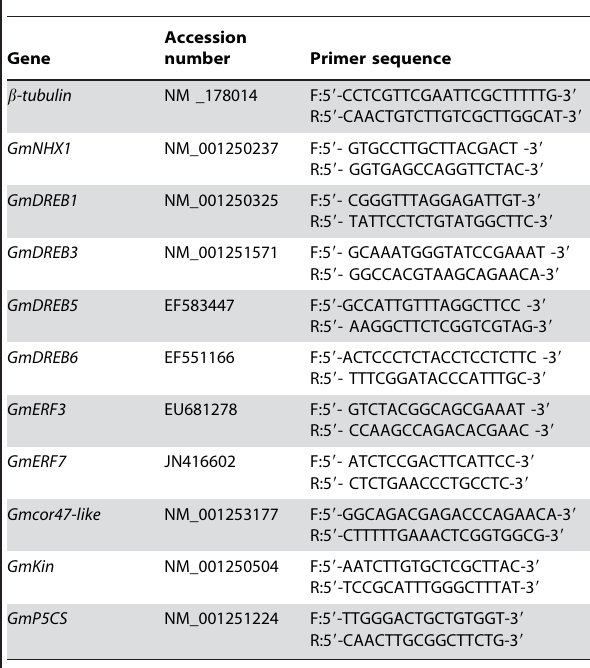
Table 1. Primers used in this article.